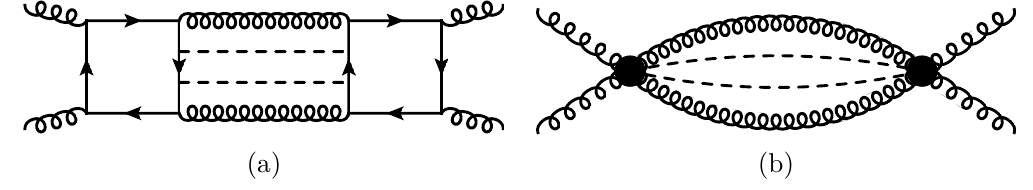
Figure 4 . (a) An example “full” Feynman diagram, which contributes to the real-real-virtual corrections of gg → HH . There are 3600 such diagrams. (b) The equivalent “building-block” diagram, of which there is only one.